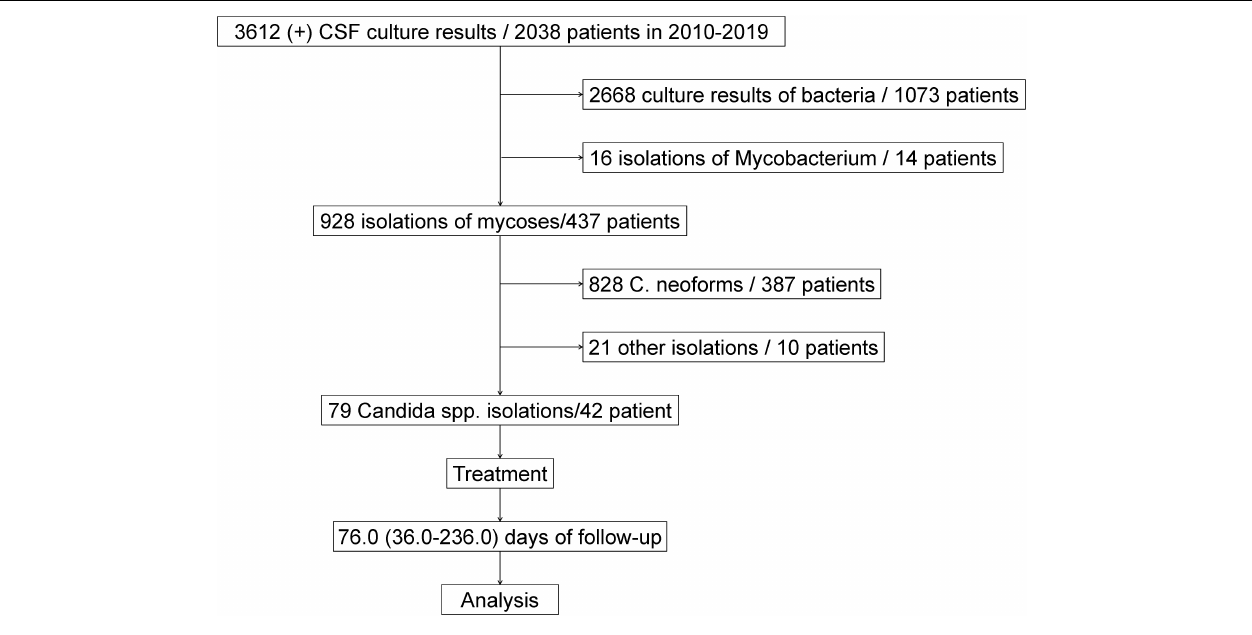
FIGURE 1 | Flowchart of patient